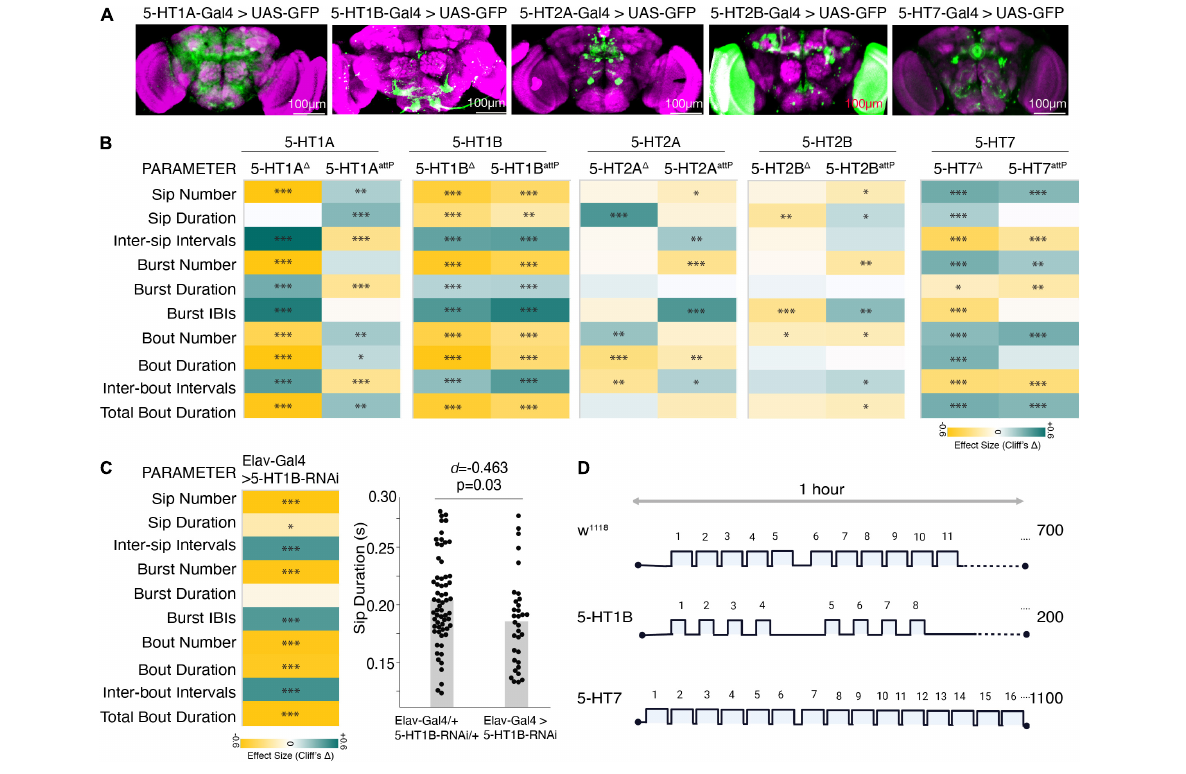
FIGURE5 Distinct 5HT receptors enhance or suppress feeding. (A) Maximum intensity projections of Gal4 driven 5-HT receptors in the brain expressing mcD8:GFP and immunostained with anti-Dlg, a neuropil labeling antibody. Scale bar is 100 um. (B) Heatmap showing Cliff’s (cid:49) effect sizes for changes between the receptor mutants and wild-type flies (as shared control) for all the parameters measured by the FlyPAD. (C) Heatmap shows the effects as changes in feeding parameters (Cliff’s (cid:49) ) between Elav-Gal4 driven 5-HT1B-RNAi compared to its genotypic controls (Elav-Gal4/+ and UAS-5-HT1B-RNAi/+ combined) and estimation plot showing the reduction in sip duration upon RNA interference. [ d = –0.463, (95%CI –0.82, –0.1), p = 0.03]. (D) Representative schematic comparing the changes in feeding microstructure parameters with the receptor mutants compared to wild-type (average number of sips are shown, sip durations and intervals are indicative of changes, not drawn to scale). In the heatmap, green indicates an increase in effect size, and yellow indicates a decrease in effect size. p -values for the effect size measure are indicated with an asterisk ∗ p < 0.05, ∗∗ p < 0.01, and ∗∗∗ p <